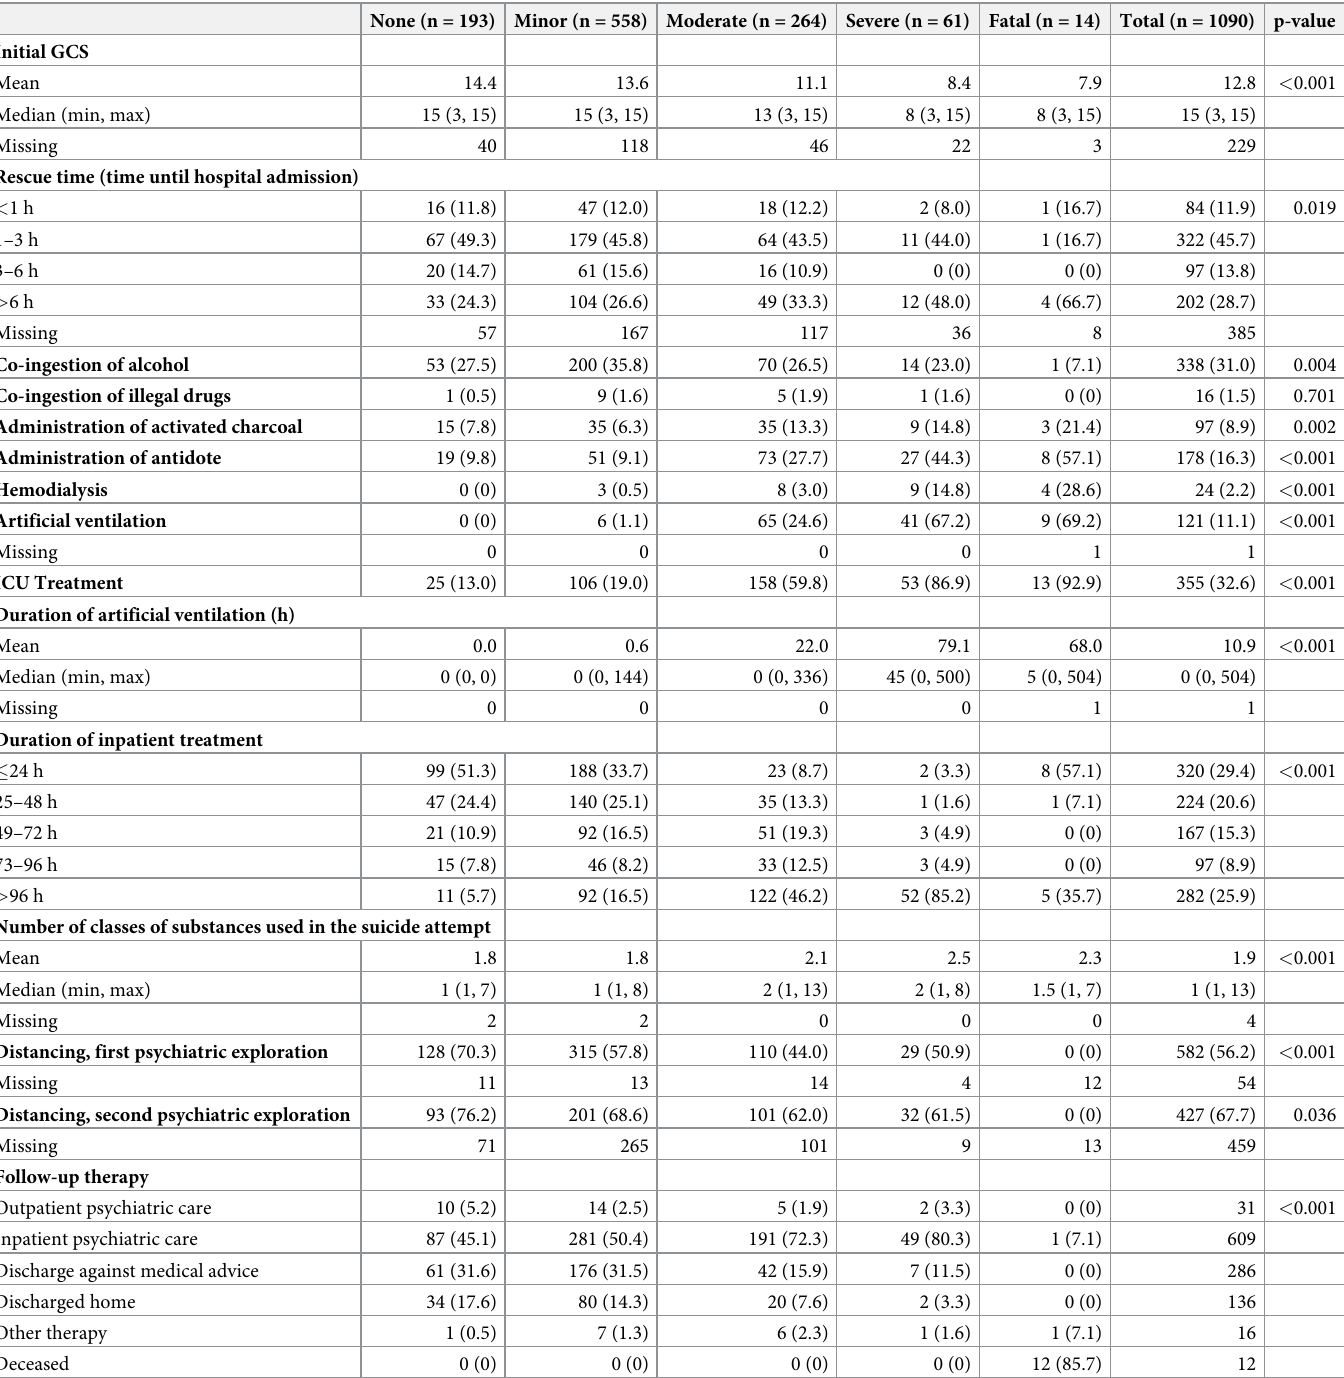
Table 3. Relationship between (pre-)clinical parameters and severity of